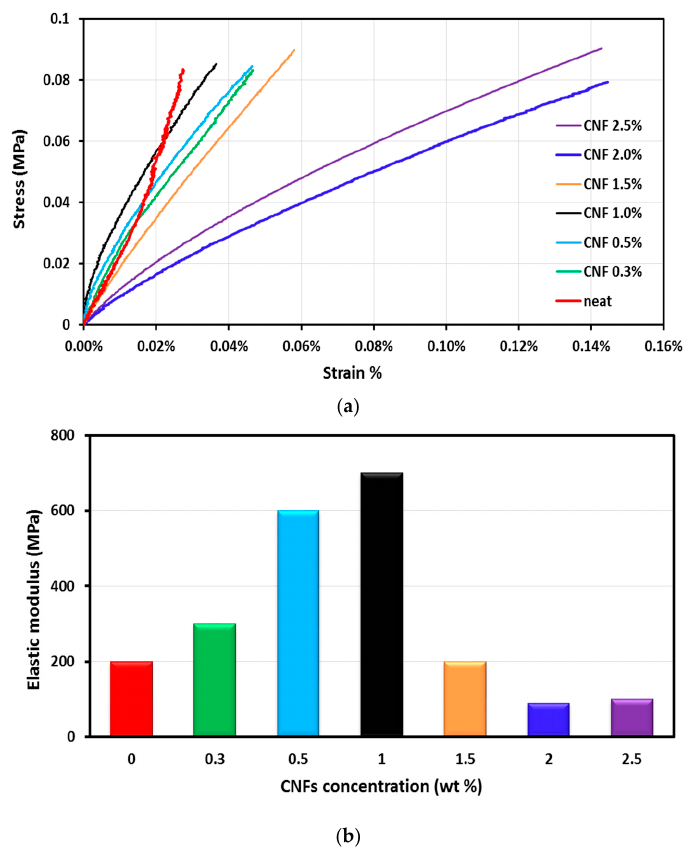
Figure 4. ( a ) The stress-strain relationship for CNFs/epoxy nanocomposites; and ( b ) the change in elastic modulus versus the CNFs concentrations for CNFs/epoxy nanocomposites.